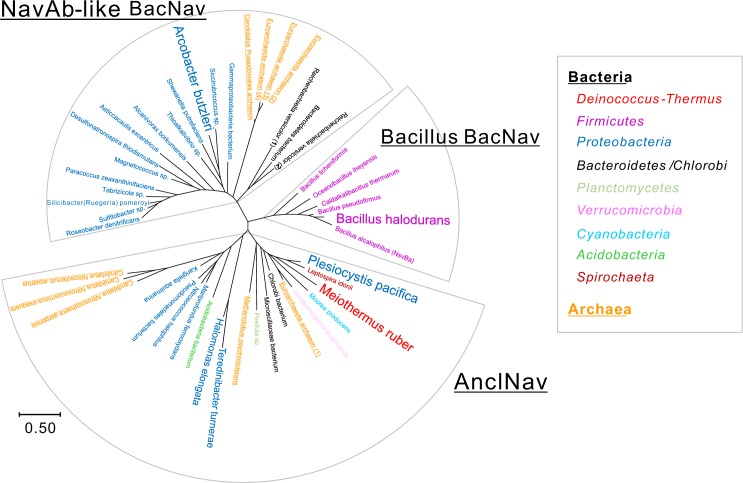
Distribution of the bacterial phylum and archaea in the phylogenetic tree of BacNavs.Bacterial species that have a BacNav homolog are separately colored according to their different phyla, plus the archaea colored in orange. The branch lengths are proportional to the sequence divergence, with the scale bar corresponding to 0.5 substitutions per amino acid position.